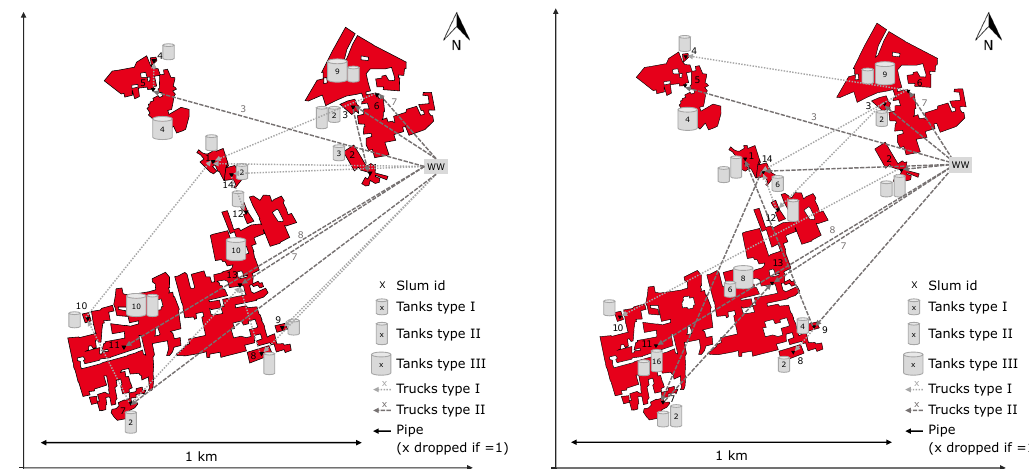
Figure 15. Optimization result for a slum cluster in Dhaka 2010, Bangladesh, with 14 slums (left) for a cost calculation period of five years and with a period of 15 years